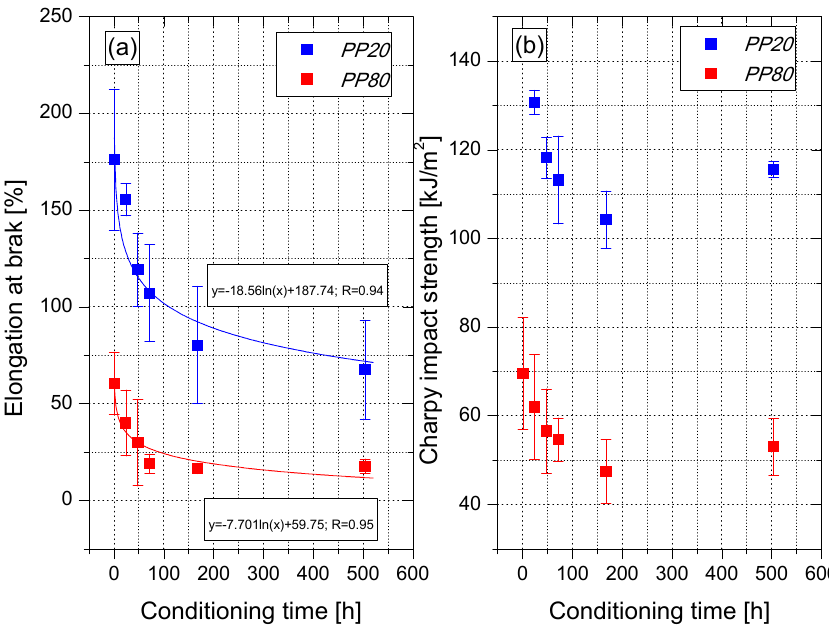
Figure 8. Elongation at break ( a ) and Charpy impact strength ( b ) of PP samples in the function of conditioning time.